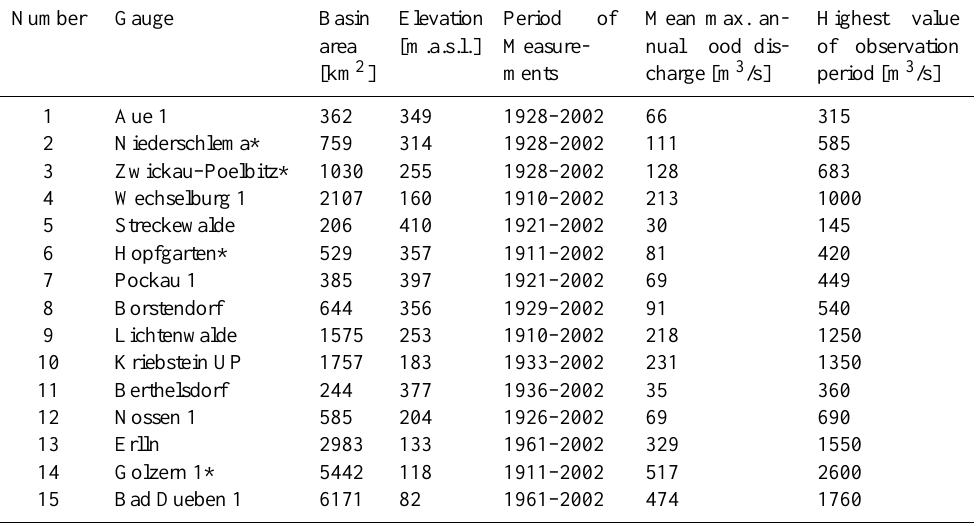
Table 1. Analyzed discharge gauges in the study area (* stations with one year of missing